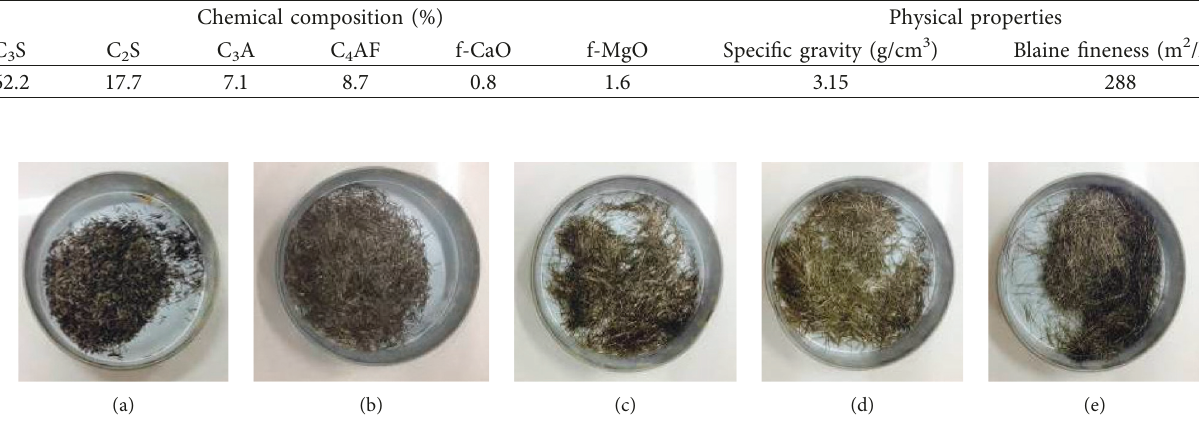
Table 1: Chemical composition and physical properties of cement.